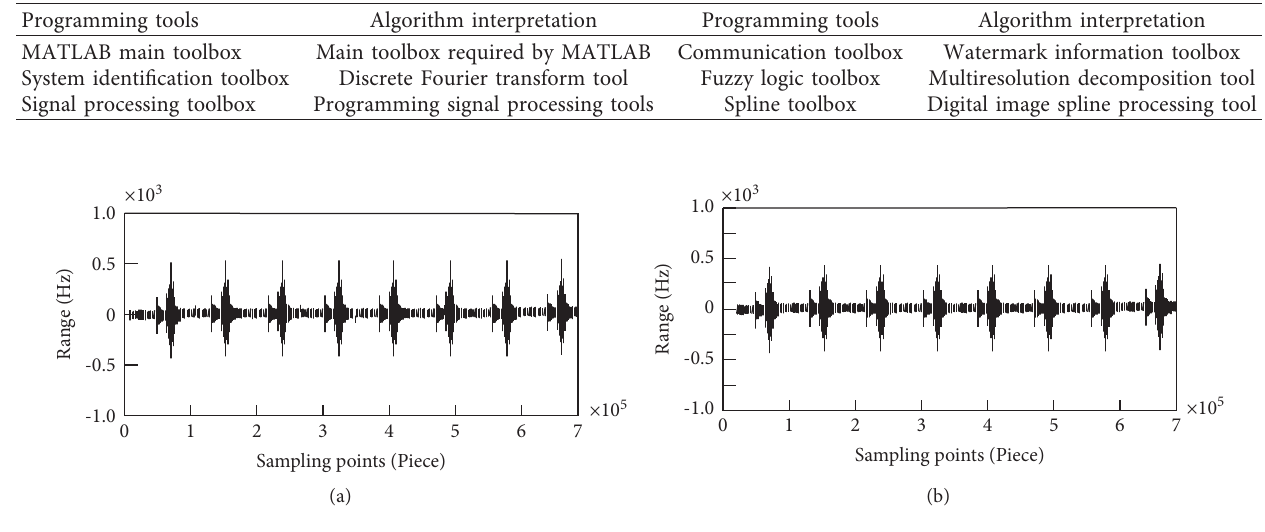
Figure 3: Amplitude value of image signal. Table 2: Comparison results of normalized correlation coefficients of different algorithms.